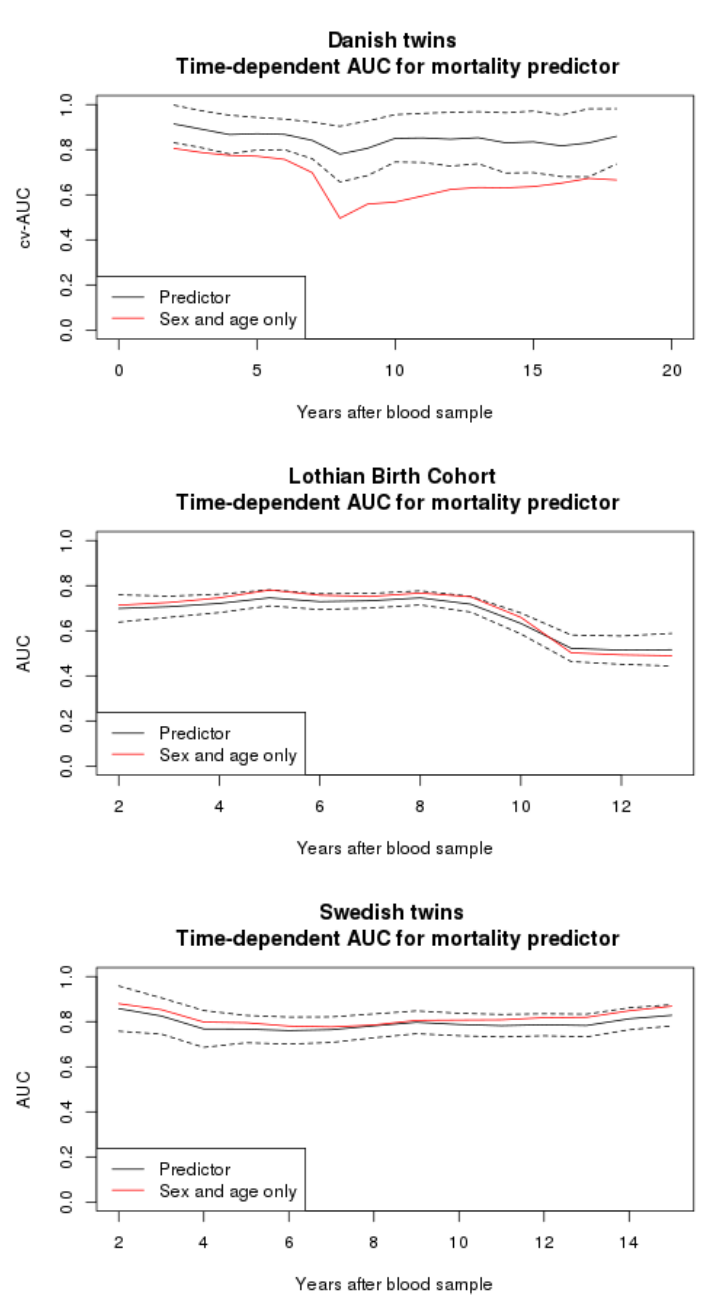
Figure 2. The 10-fold cross-validated time-varying AUC for the LASSO predictor based on all 14 CpG sites, sex, and age. This is compared to the model based on sex and age only.